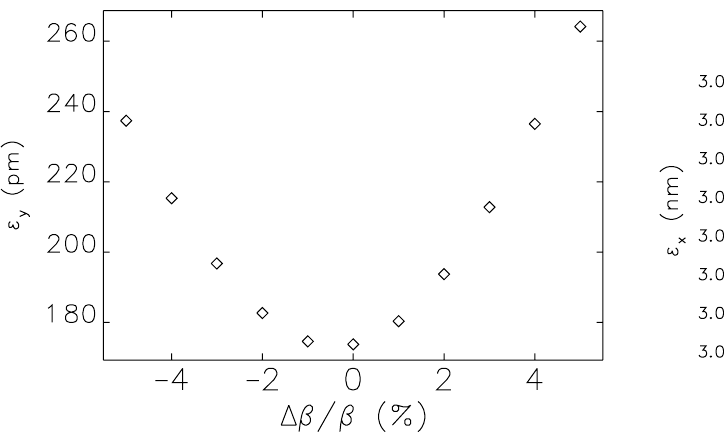
FIG. 15. Eventual vertical emittance as a function of beta- function difference between the two crab cavities, for h (cid:3) 8 and V (cid:3) 4 MV